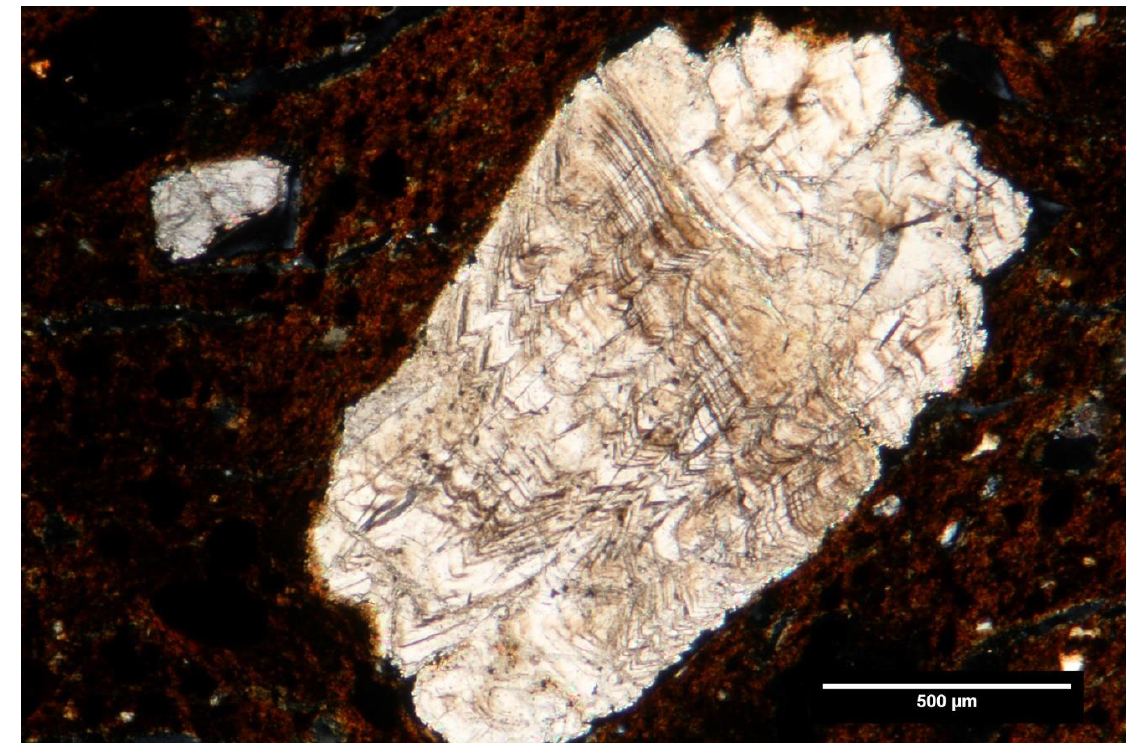
Figure 9. A large calcite grain within sample MOX-34 containing the banded deposition layers characteristic of speleothem formation processes. Photomicrograph taken under crossed-polars by Jennifer Meanwell.